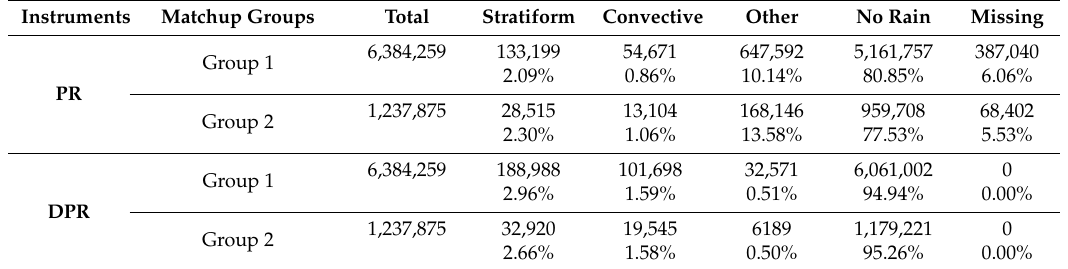
Table 4. The rain type classification results for TRMM PR and GPM DPR based on all the coincident